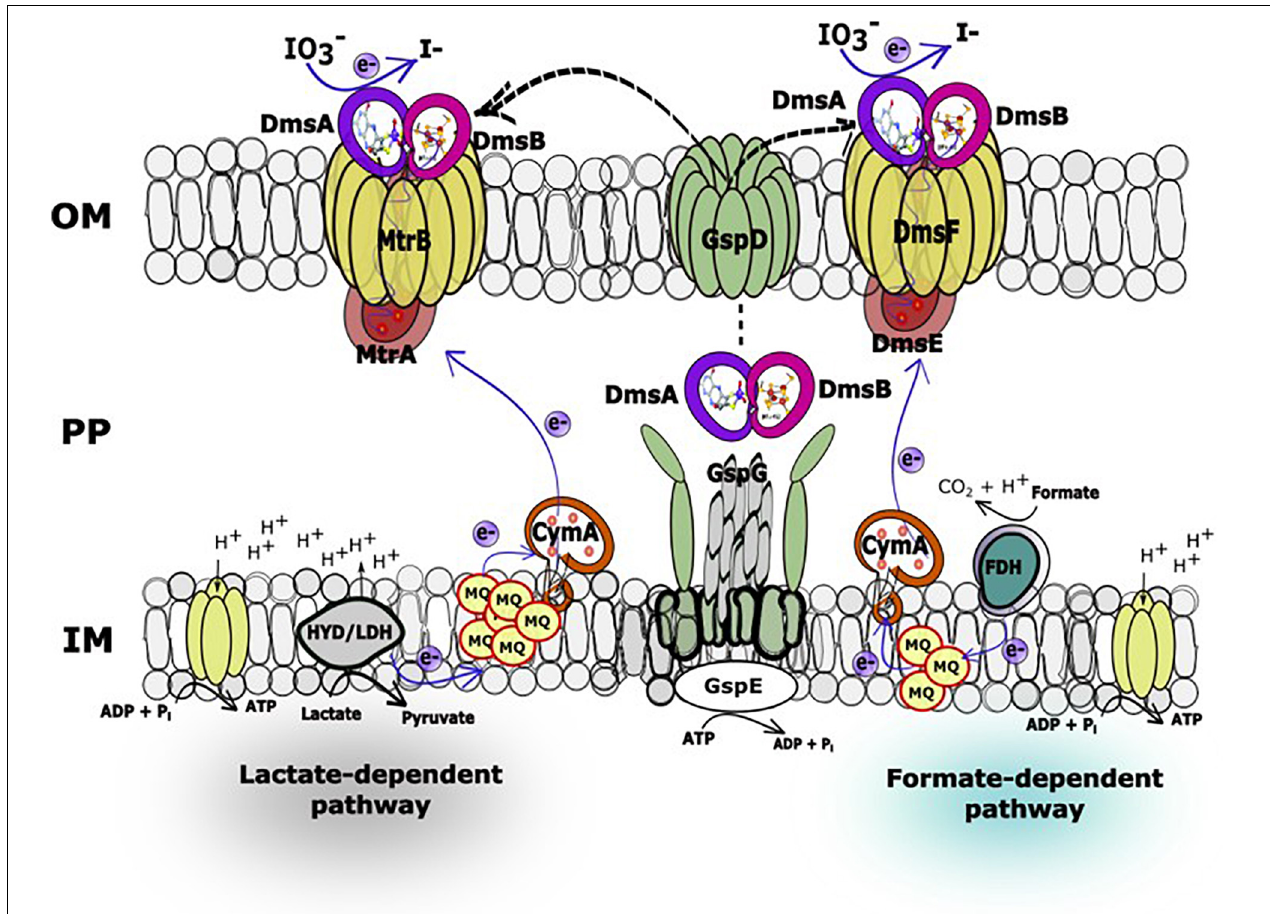
FIGURE 5 | Hypothetical working model of the lactate (MtrAB)- and formate (DmsEF)-dependent IO 3 − reduction electron transport pathways in Shewanella oneidensis. In the IO 3 − reduction pathways, electrons originating from lactate dehydrogenase or formate dehydrogenase located at the head end of the electron transport chain are transferred to the inner membrane-localized menaquinone pool and subsequently to CymA, which facilitates electron transfer across the periplasmic space to decaheme c -type cytochromes MtrA or DmsE, respectively. At this location in the electron transport chain, the IO 3 − reduction pathways diverge to MtrAB (lactate as electron donor) or DmsEF (formate as electron donor) and terminate with DmsA and DmsB, both of which associate with MtrA (or DmsE) and β -barrel protein MtrB (or DmsF). DmsA and DmsB are both secreted extracellularly by the type II protein secretion system to form a ternary complex with the MtrAB (or DmsEF) EEC modules on the outside face of the outer membrane (Gralnick et al.,